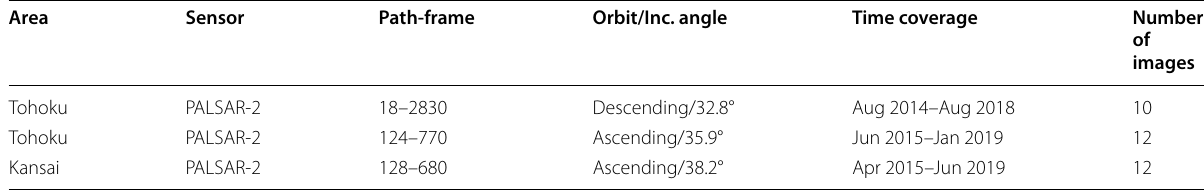
Table 1 SAR images information for the Tohoku and Kansai regions Area